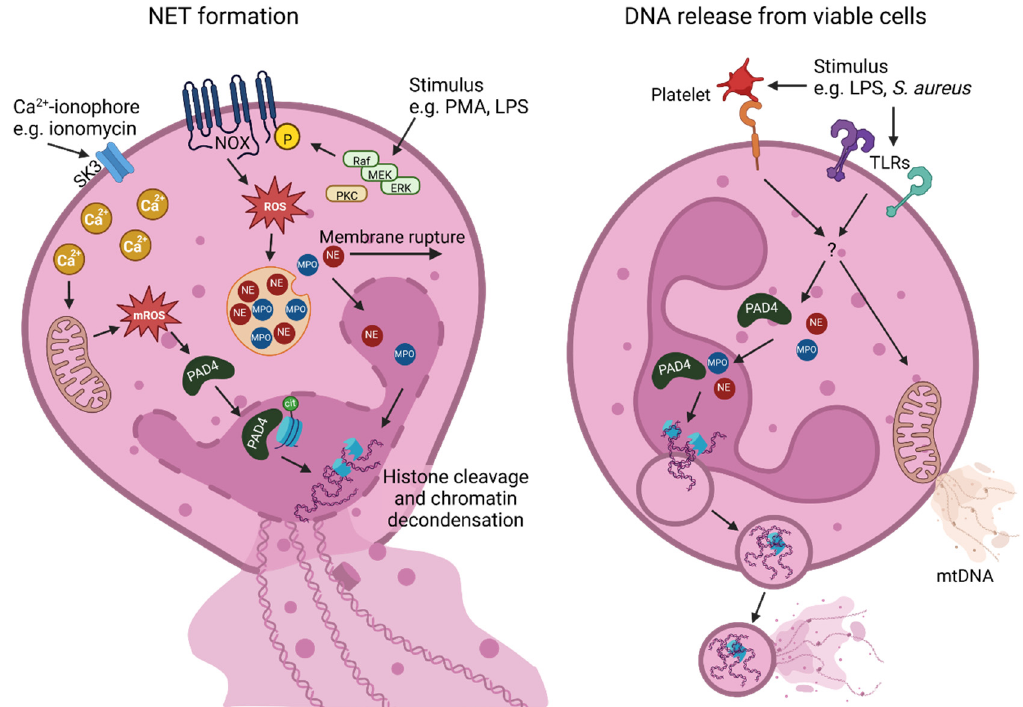
Figure 1. NET formation mechanisms and their components. Two main types of NET formation are reported: NOX-independent and NOX-dependent. Both types lead to histone cleavage and chroma- tin decondensation and are lethal to the cell. The NOX-independent pathway is triggered by calcium ionophores such as ionomycin, which promotes calcium influx and mitochondrial ROS production. This induces translocation of PAD4 to the nucleus, where it citrullinates histones. The NOX-depend- ent pathway, triggered by stimuli such as PMA and LPS, activates the Raf–Merk–Erk pathway and leads to ROS-dependent release of MPO and NE from the azurosome. These enzymes mediate rup- ture of the membrane, nuclear envelope breakdown, and chromatin decondensation inside the nu- cleus. While calcium, mROS, and ROS can be clearly assigned to the NOX-independent or -depend- ent pathway, respectively, it is not yet clear whether PAD4, MPO, and NE act in both pathways. Another form of NET generation involves DNA release from viable cells after neutrophil activation by stimuli such as S. aureus, LPS, or LPS-activated platelets. The exact mechanisms remain elusive. There are two ways the cell can survive DNA release. Either the DNA is released via vesicles, which maintains membrane integrity and allows the cell to retain some physiological functions, or the cells release only non-functional mitochondrial DNA. Created with BioRender.com. 3. Physiological Functions of NETs and Removal of NETs Remnants Traditionally, neutrophils were considered as part of the only innate immunity. They are recruited very early to the site of infection/inflammation. Here, they immobilize and kill invaders to prevent their dissemination. When their mission is accomplished, neutro- phils are eliminated from the “battlefield” to maintain tissue homeostasis. Otherwise, the prolonged presence of neutrophils in the inflammatory site may delay the healing process [47,56]. To maintain homeostasis, neutrophils often undergo apoptosis and are cleared by macrophages or non-professional tissue phagocytes. Some neutrophils reportedly return via vasculature to the bone marrow for clearance [57]. The antimicrobial arsenal of neutrophils includes degranulation, phagocytosis, oxi- dative burst, NET formation, and recruitment of further immune cells [58]. Neutrophils also influence the adaptive immune response, since they secrete a plethora of inflamma- tory mediators, including the B cell activation factors BAFF and APRIL [59], and they re- portedly induce responses in surrounding lymphocytes and dendritic cells [60,61]. Not only neutrophils but also NETs participate in this cross-talk that occurs through direct cell contact or via soluble mediators [56,62]. Once NETs have been formed, extracellular DNA,